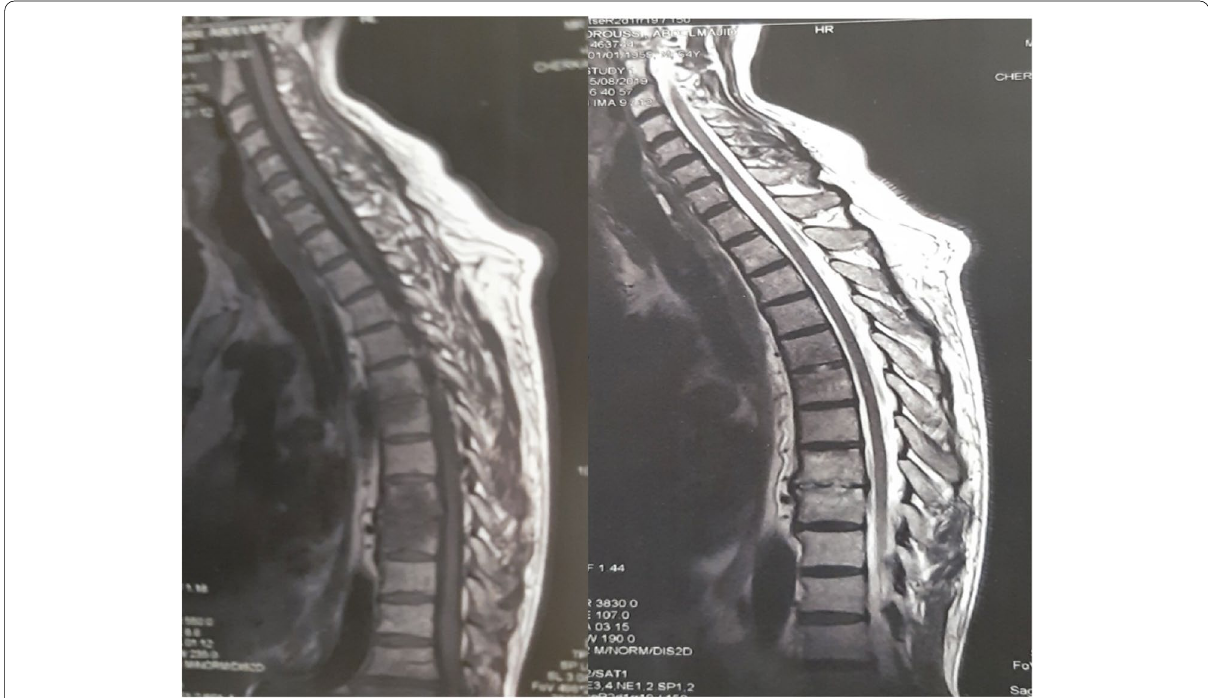
Fig. 2 MRI of the thoracolumbar spine showing T5–T6 and T8–T9 uncovered spinal damage with contrast at the two highest levels